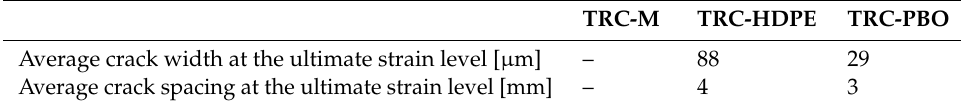
Table 5. Average crack width and spacing at the ultimate strain level for the representative specimens subjected to uniaxial quasi-static tension tests (localization crack